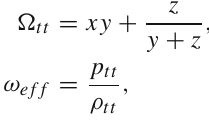
The EoS parameter for dark energy sector ω de , the Hub- ble parameter H ( z r ) and the deceleration parameter, q ( z r